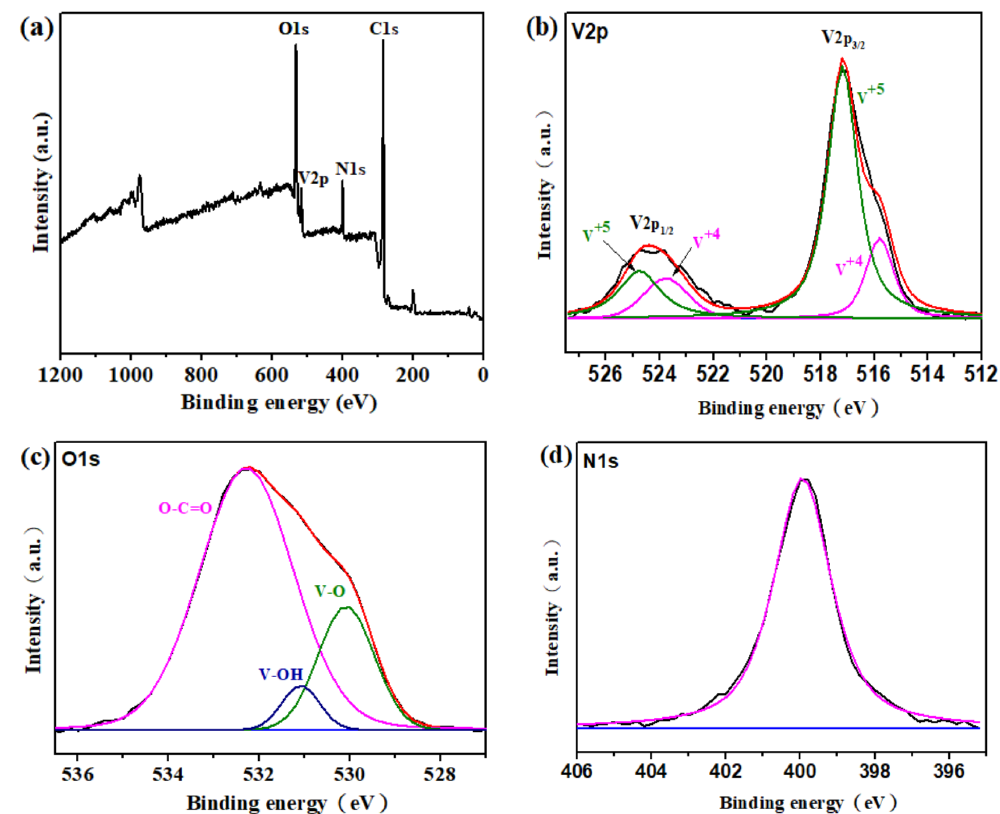
Figure 5. XPS ( a ) survey spectrum, scan of ( b ) V2p, ( c ) O1s, and ( d ) N1s of V 2 O 5 /f-CNT/PPy.